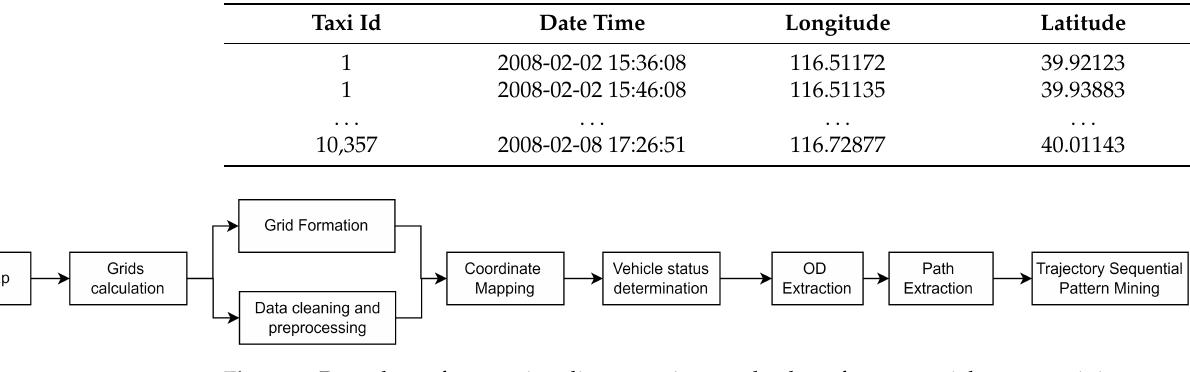
Figure 1. Procedure of generating discrete trajectory database for sequential pattern